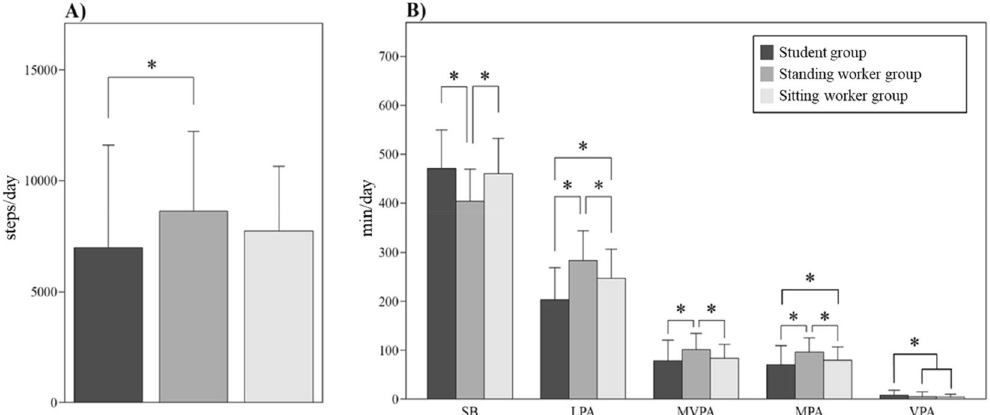
Figure 5. Step counts (A) and mean performance time of sedentary behavior (SB) and each type of physical activity (B) in the student, standing worker and sitting worker groups. LPA light physical activity; MVPA